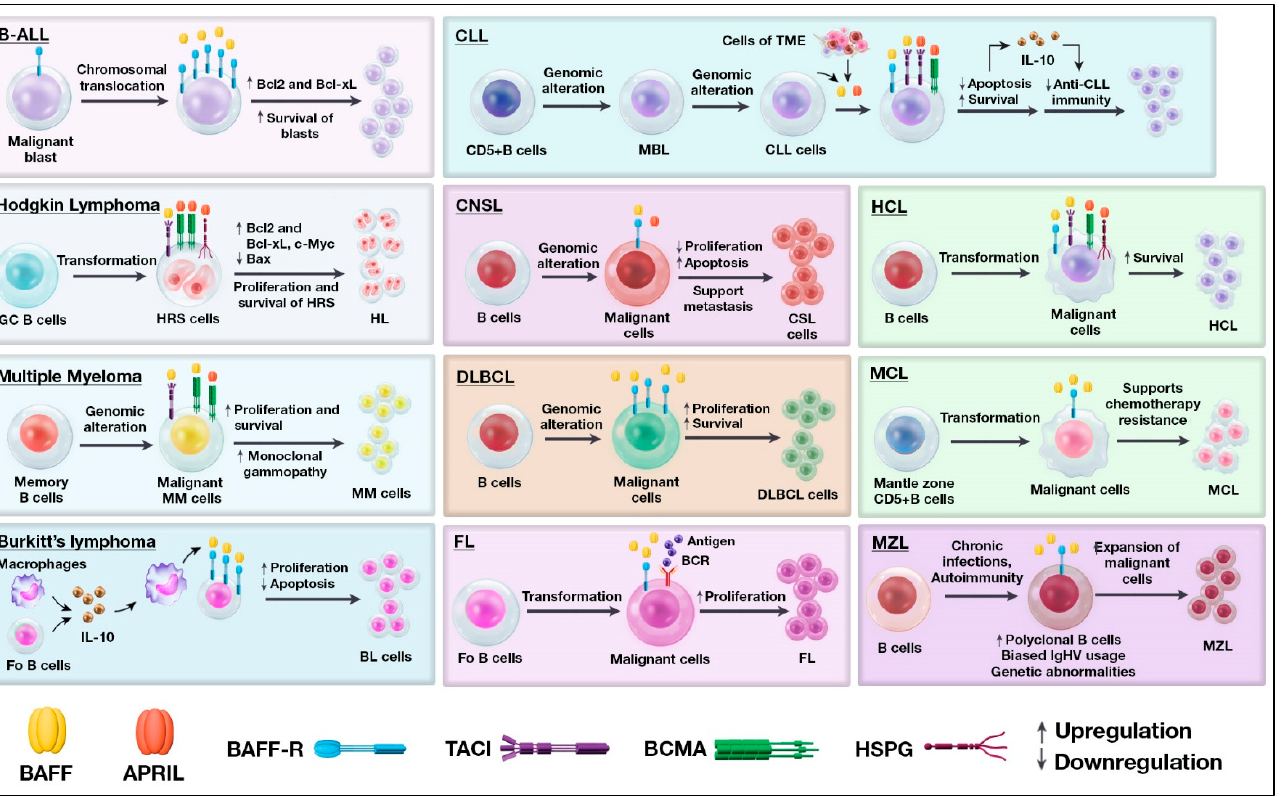
Figure 2. Role of the BAFF-APRIL system in the development of hematological cancers. Dysregulated BAFF-APRIL signaling primarily contributes to the proliferation and survival of cancer cells, outlined in this schematic, with the mechanisms of action described in the relevant sections. Abbreviations: B-ALL = B-cell acute lymphoblastic leukemia; GC B cells = germinal center B cells; HRS cells = Hodgkin and Reed–Sternberg cells; HL = Hodgkin’s lymphoma; PC = plasma cells; MM cells = multiple myeloma cells; Fo B cells = follicular B cells; Burkitt’s Lymphoma; CLL = chronic lymphocytic leukemia; MBL = monoclonal B-cell lymphocytosis; TME = tumor microenvironment; CNSL = central nervous system lymphoma; DLBCL = diffuse large B-cell lymphoma; FL = follicular lymphoma; HCL = hairy cell leukemia; MCL = mantle cell lymphoma; MZL = marginal zone lymphoma. ↑ refers to upregulation and ↓ refers to